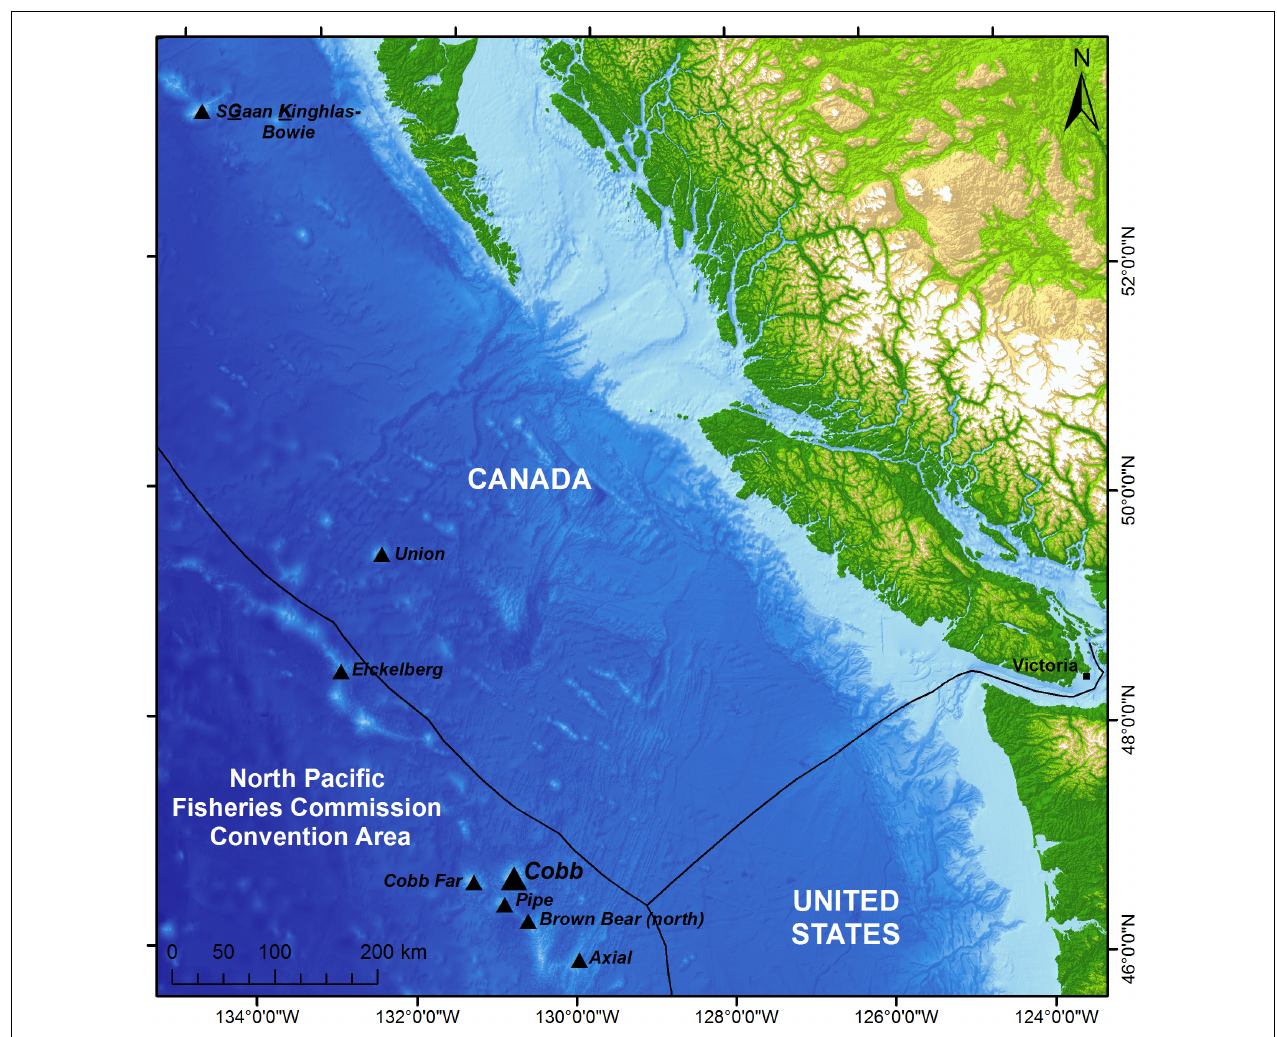
FIGURE 1 | The location of Cobb Seamount (46 ◦ 44 (cid:48) 24 (cid:48)(cid:48) N, 130 ◦ 48 (cid:48) 0 (cid:48)(cid:48) W), approximately 450 km off the west coast of Canada and the United States, within the North Pacific Fisheries Commission (NPFC) Convention Area of the High Seas. Also shown, seven notable seamounts, including SGaan Kinghlas-Bowie, the only other shallow-water seamount in the region (within the photic zone). The Exclusive Economic Zones are outlined.